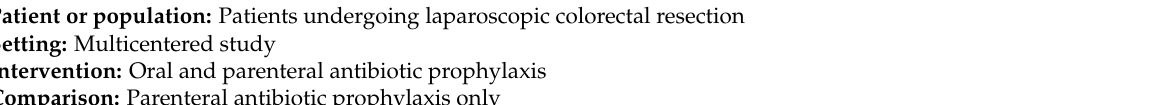
Table 2. Summary of Findings (SoF)